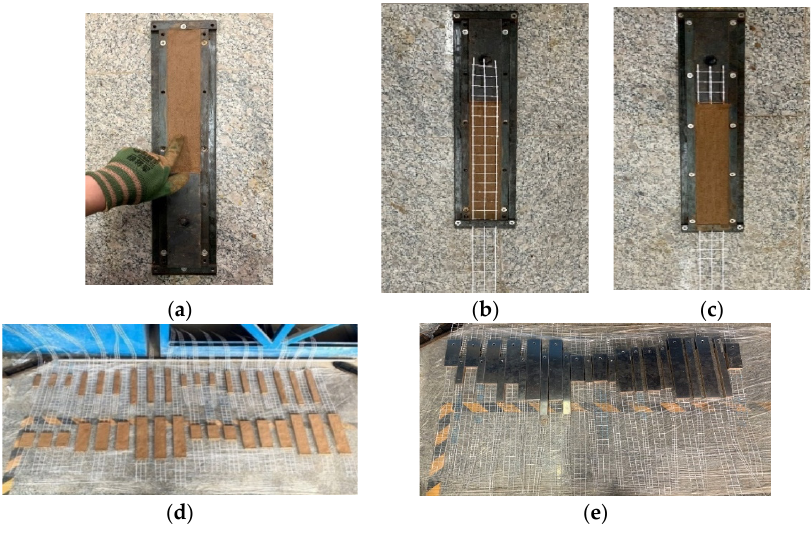
Figure 3. Samples preparation: ( a ) place a layer of the mortar, ( b ) place one layer of glass textile mesh, ( c ) place one layer of glass textile mesh, ( d ) demold curing, and ( e ) fix the aluminum plate.